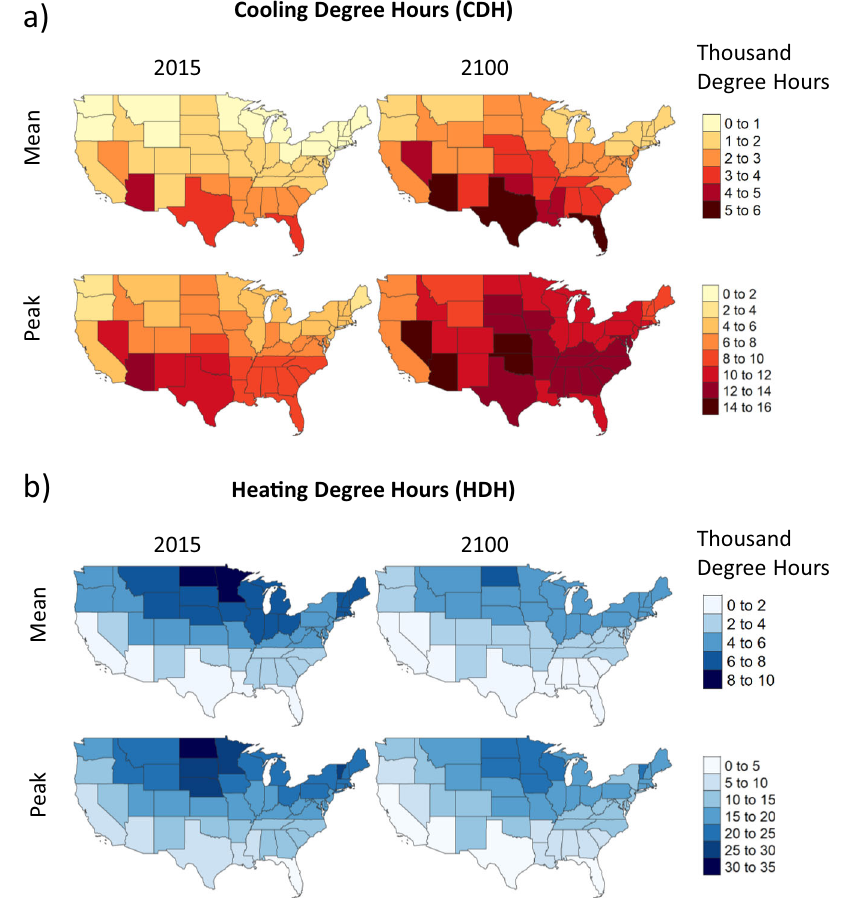
Fig. 1 Annual mean and peak degree hours under RCP 8.5 w/ temperature impacts scenario in 2015 and 2100. a Cooling degree hours (CDH) b Heating degree hours (HDH). Degree hours are calculated as the difference in temperature in (°F) from a threshold temperature of 65 °F in a given hour. Cooling and heating degree hours correspond, respectively, to positive and negative differences. Mean and peak degree hours are calculated as the average and maximum difference over the full year. See “ Methods ” for more calculations and